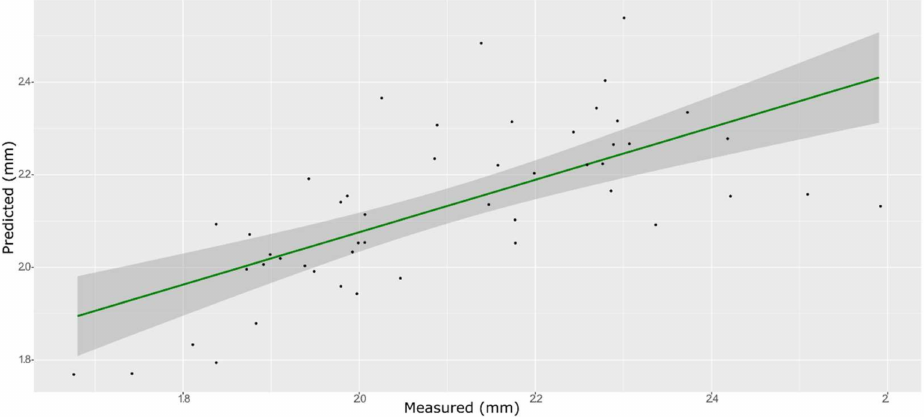
Figure 6. PLS model for BS on the test set, using the full spectral range.